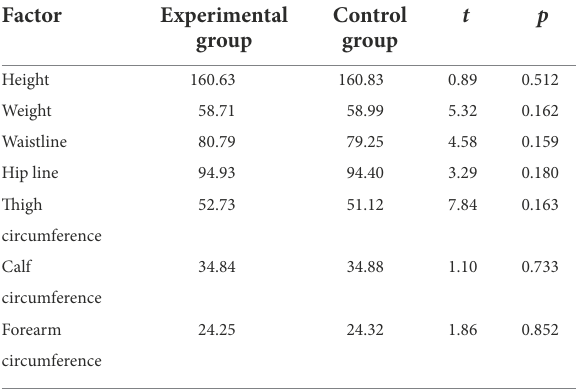
silver-haired people in the experimental group before and after the experiment. (1: height; 2: weight; 3: waist circumference; 4: hip circumference; 5: thigh circumference; 6: calf circumference; 7: forearm circumference; * indicates a significant